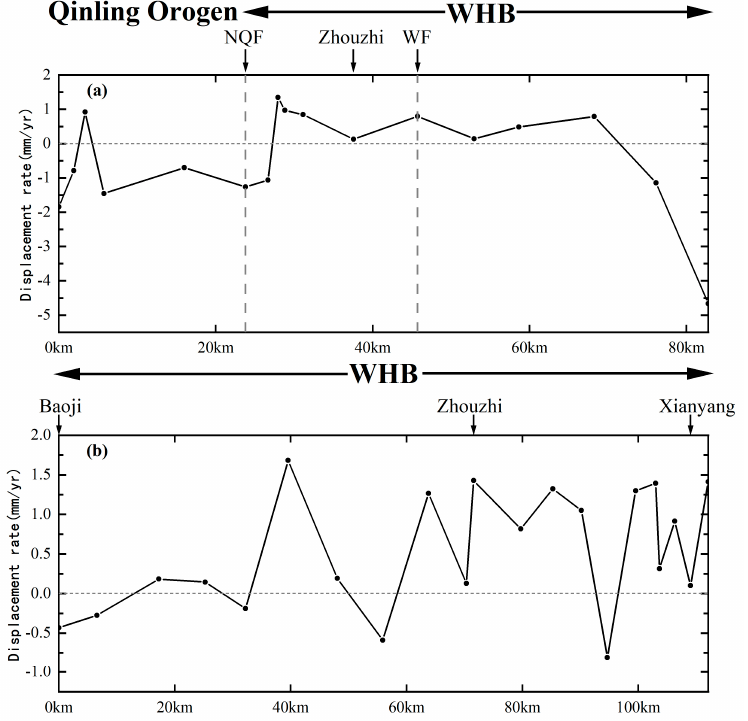
Figure 12. Displacement rate map of profiles P4 and P6 in Weihe Basin. ( a ) P4, and ( b ) P6. Abbreviations are the same as those used in Figure 1.